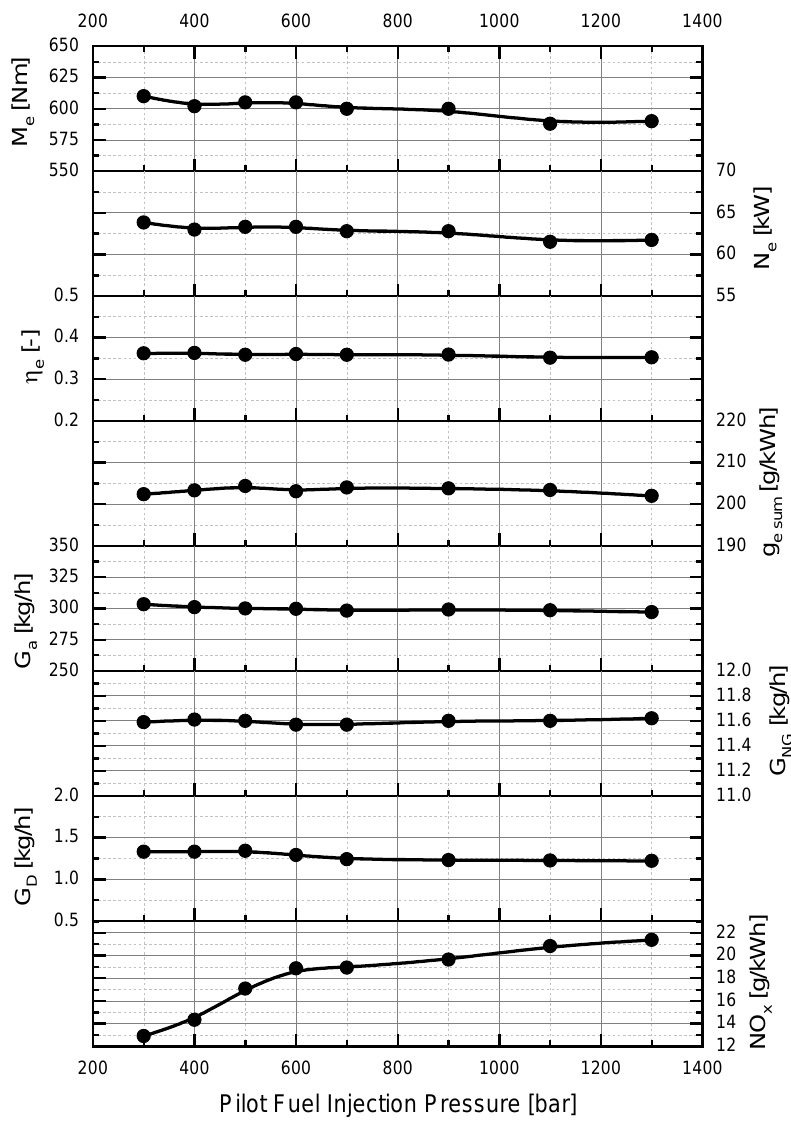
Figure 5. Engine parameters versus pilot fuel injection pressure (n = 1000